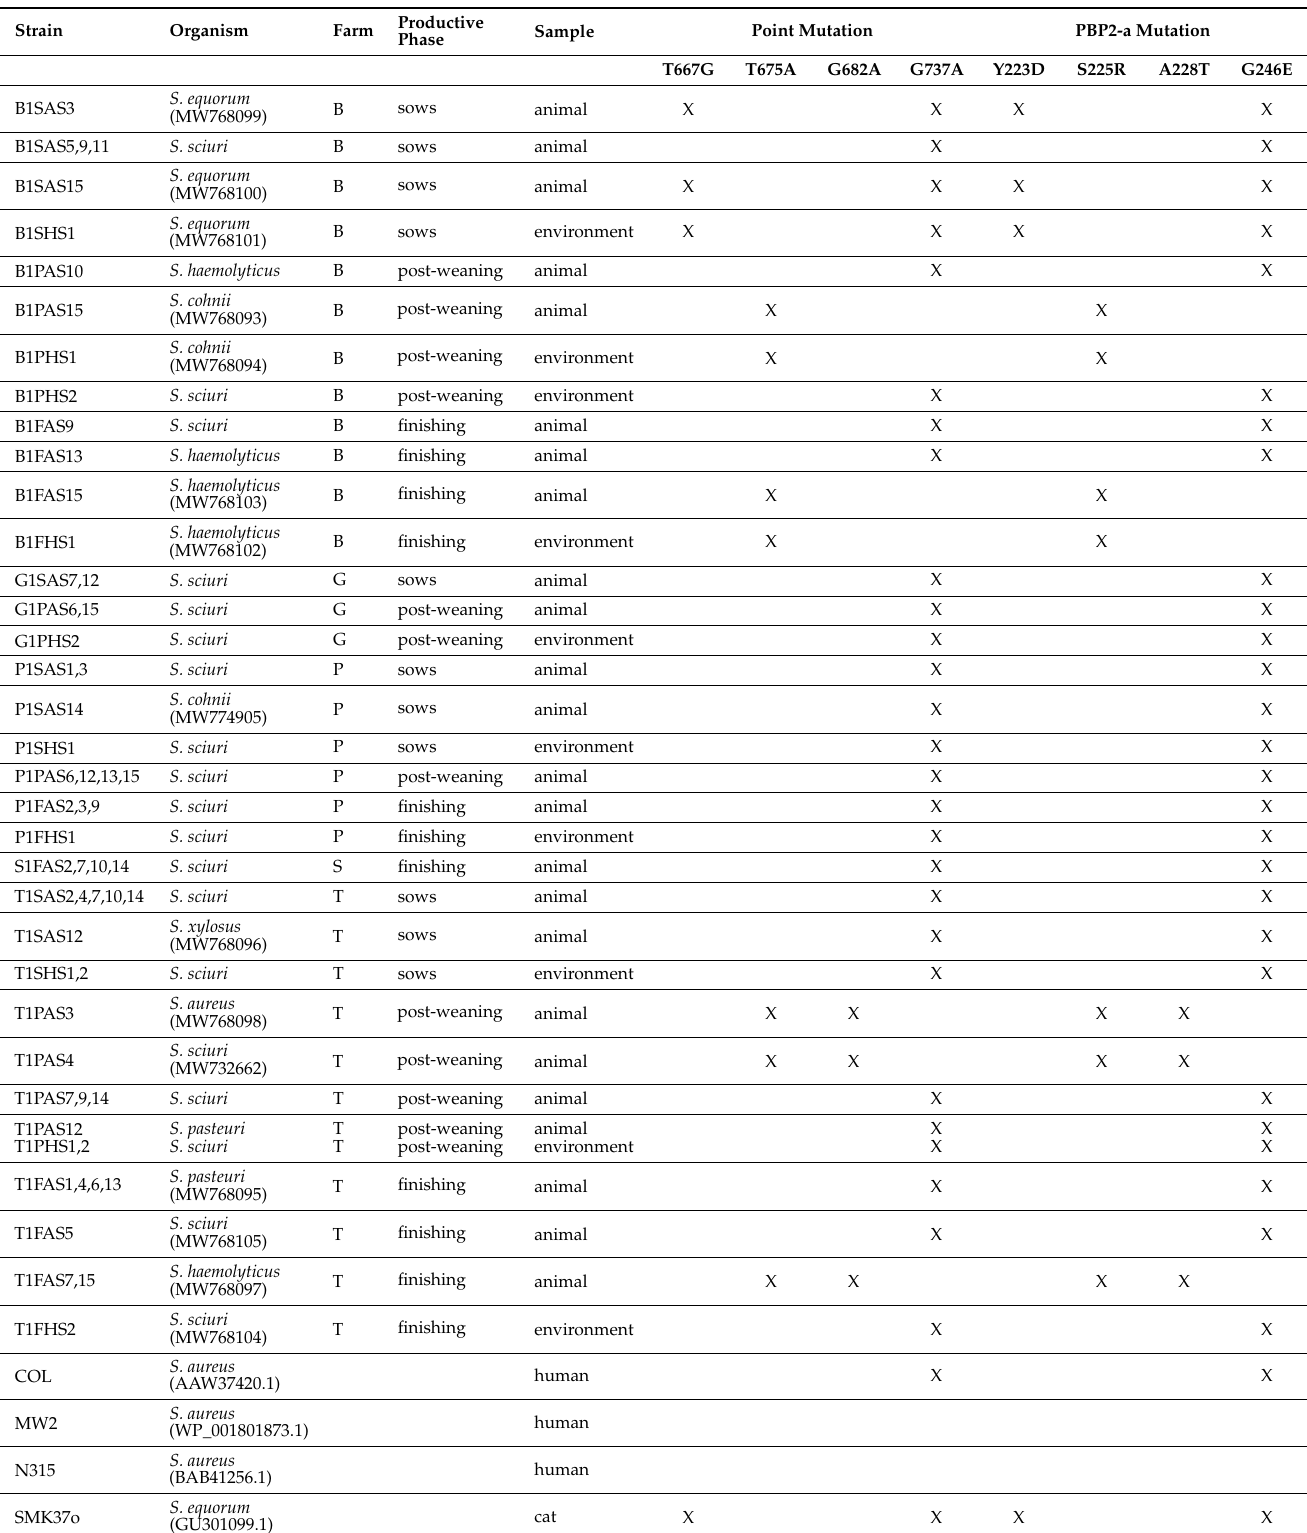
Table 3. Point mutations and PBP2-a aminoacidic substitutions in MRS isolated in five farms in northern Italy, 2019–2020, by productive stage (sows, post-weaning and finishing). Reference strains MRSA COL, MW2, N315 and MR- S. equorum SMK37o were